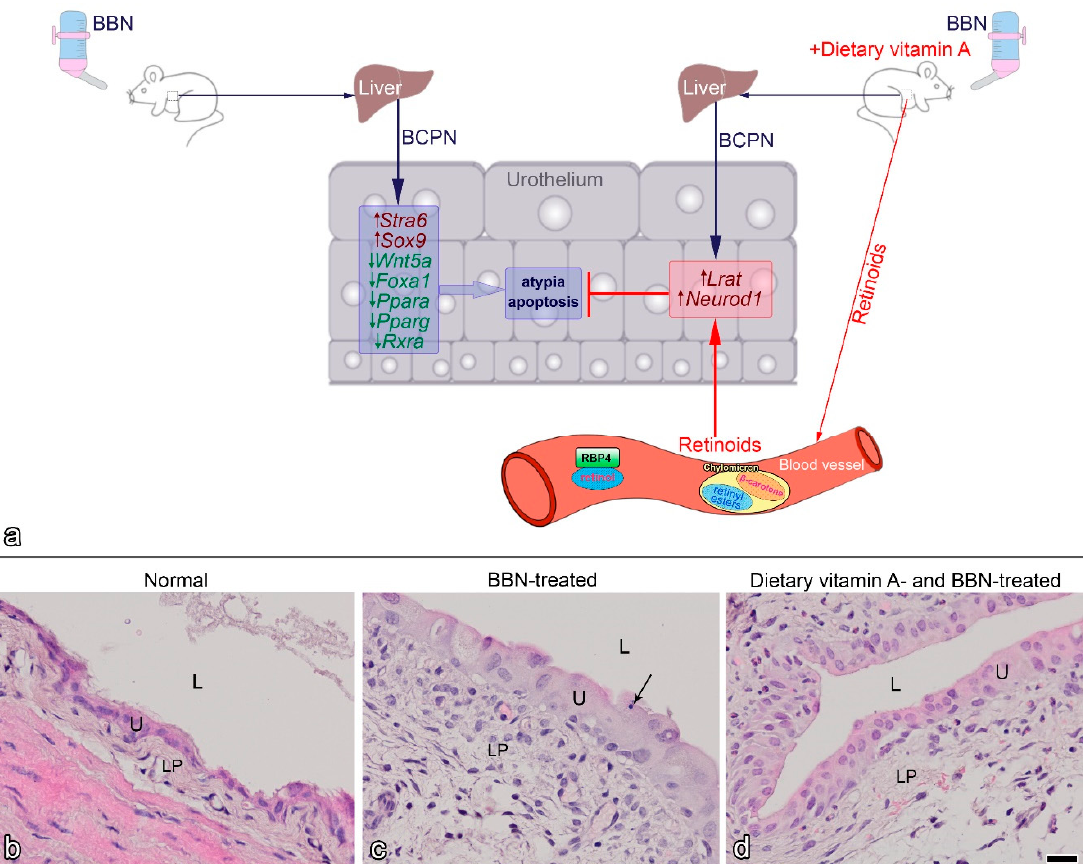
Figure 3. Proposed model of BBN-induced early bladder carcinogenesis and the effects of dietary vitamin A (modified from [89]) ( a ). BBN (N-butyl-N-(4-hydroxybutyl)-nitrosamine) administered orally to experimental mice via drinking water is metabolized in the liver to BCPN (N-butyl-N-(3-carboxypropyl)-nitrosamine), which reaches urothelium through urine and can affect urothelial cells. BCPN binds to cellular macromolecules, including DNA, and initiates the early carcinogenic process in urothelial cells, manifested by altered RA signalling. Expression of the RA receptor Stra6 and the